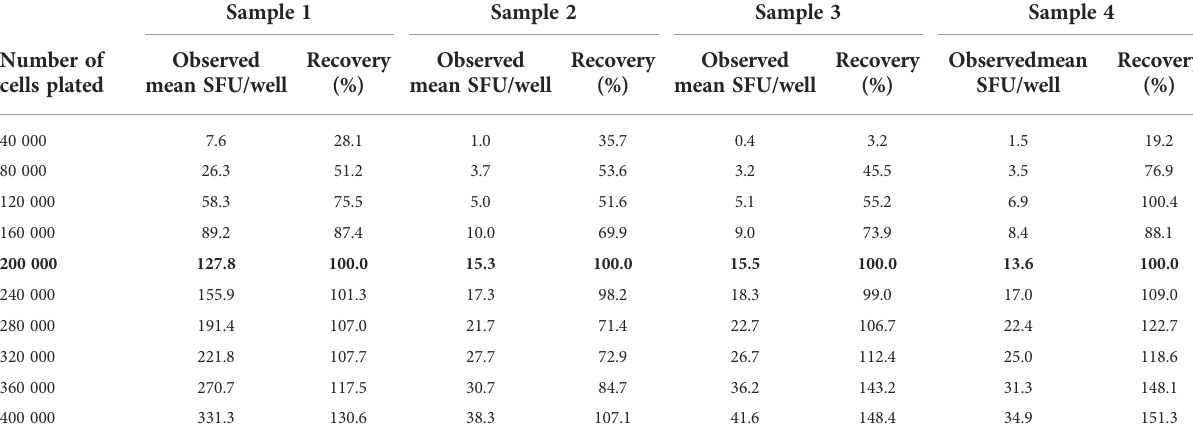
TABLE 2 Observed SFU per well at each dilution and